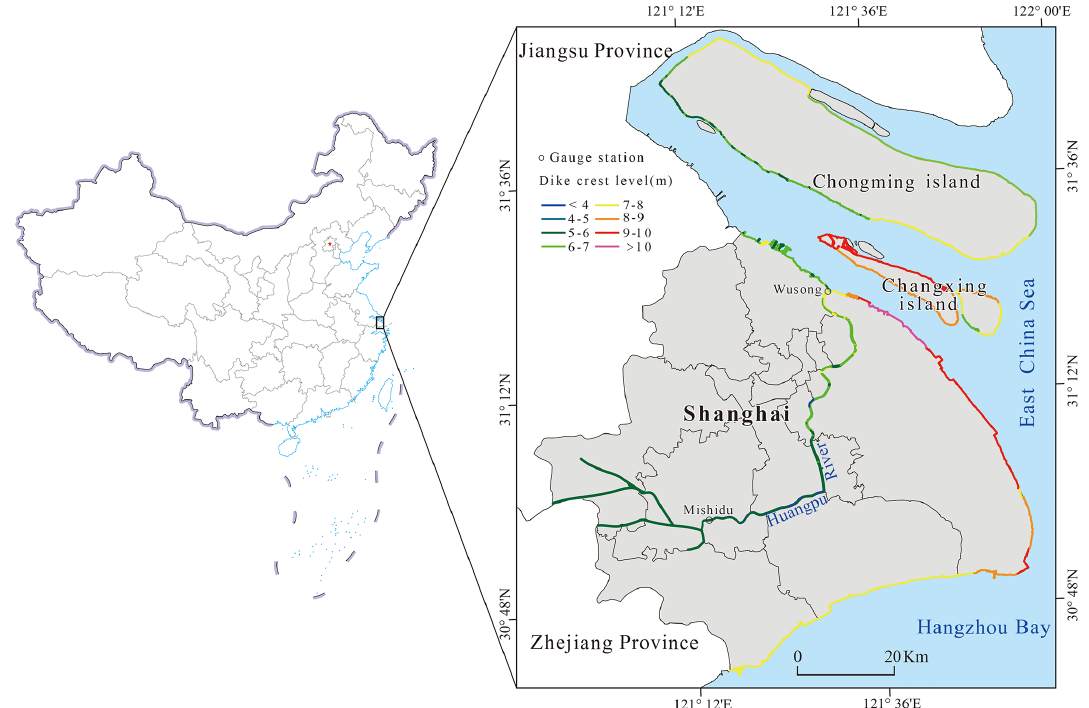
Figure 1. Location map of the study area. The main inland rivers in Shanghai flow into the East China Sea through the Huangpu River. The lines with colored vectors in the figure indicate the different dike crest levels in